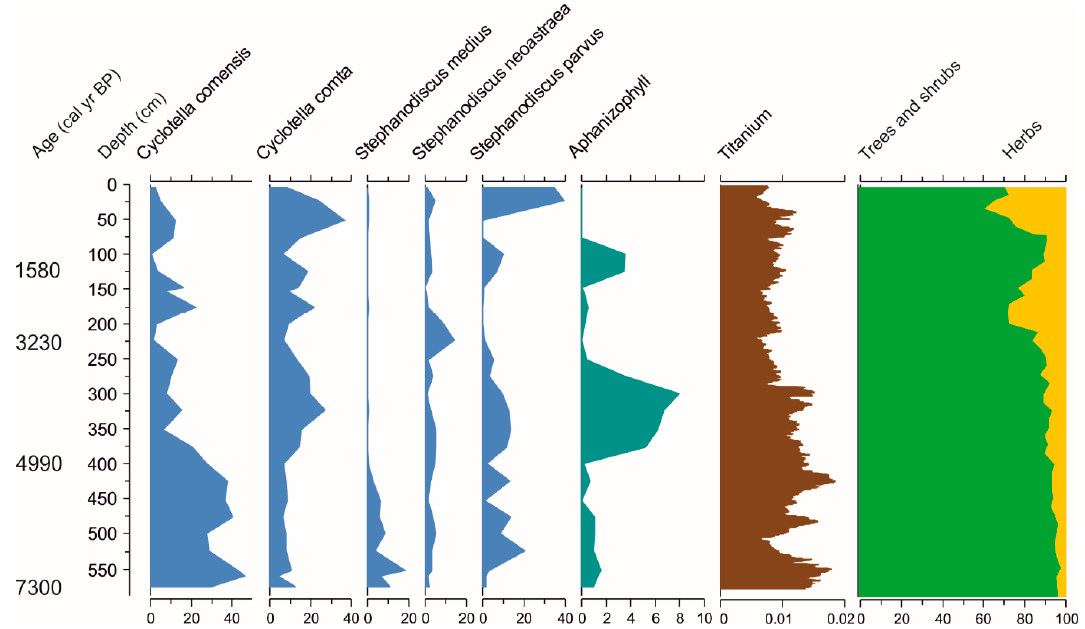
Figure 8. Percentage abundance of dominant diatom species, concentrations (nmol/g DW) of the filamentous cyanobacteria pigment aphanizophyll, normalized titanium data, and the percentage abundance of tree/shrub and herb pollen in Lake Nørresø sediment core. Sediment depth and calibrated ages are given on the left.